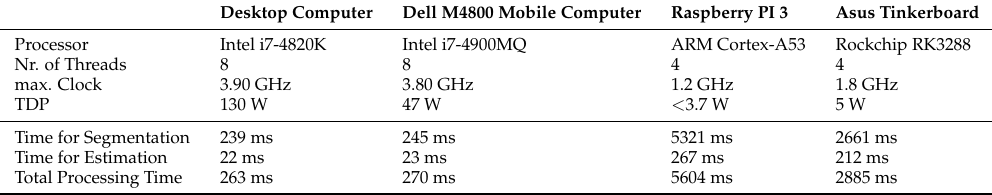
Table 3. Tested hardware including time measurements for the estimation: The biggest part of processing time is used to segment the patient from the environment. In contrast to that, the extraction of the features and the processing via an artificial neural network is small. The total time includes visualization and logging during the